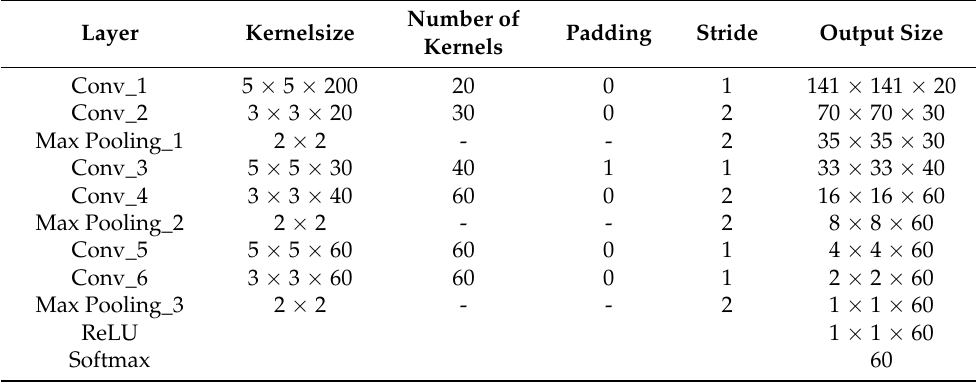
Figure 2. Structure of the down-sampling in the proposed CNN model (Taking Indian Pines dataset as an example). Table 1. Parameters setting in CNN